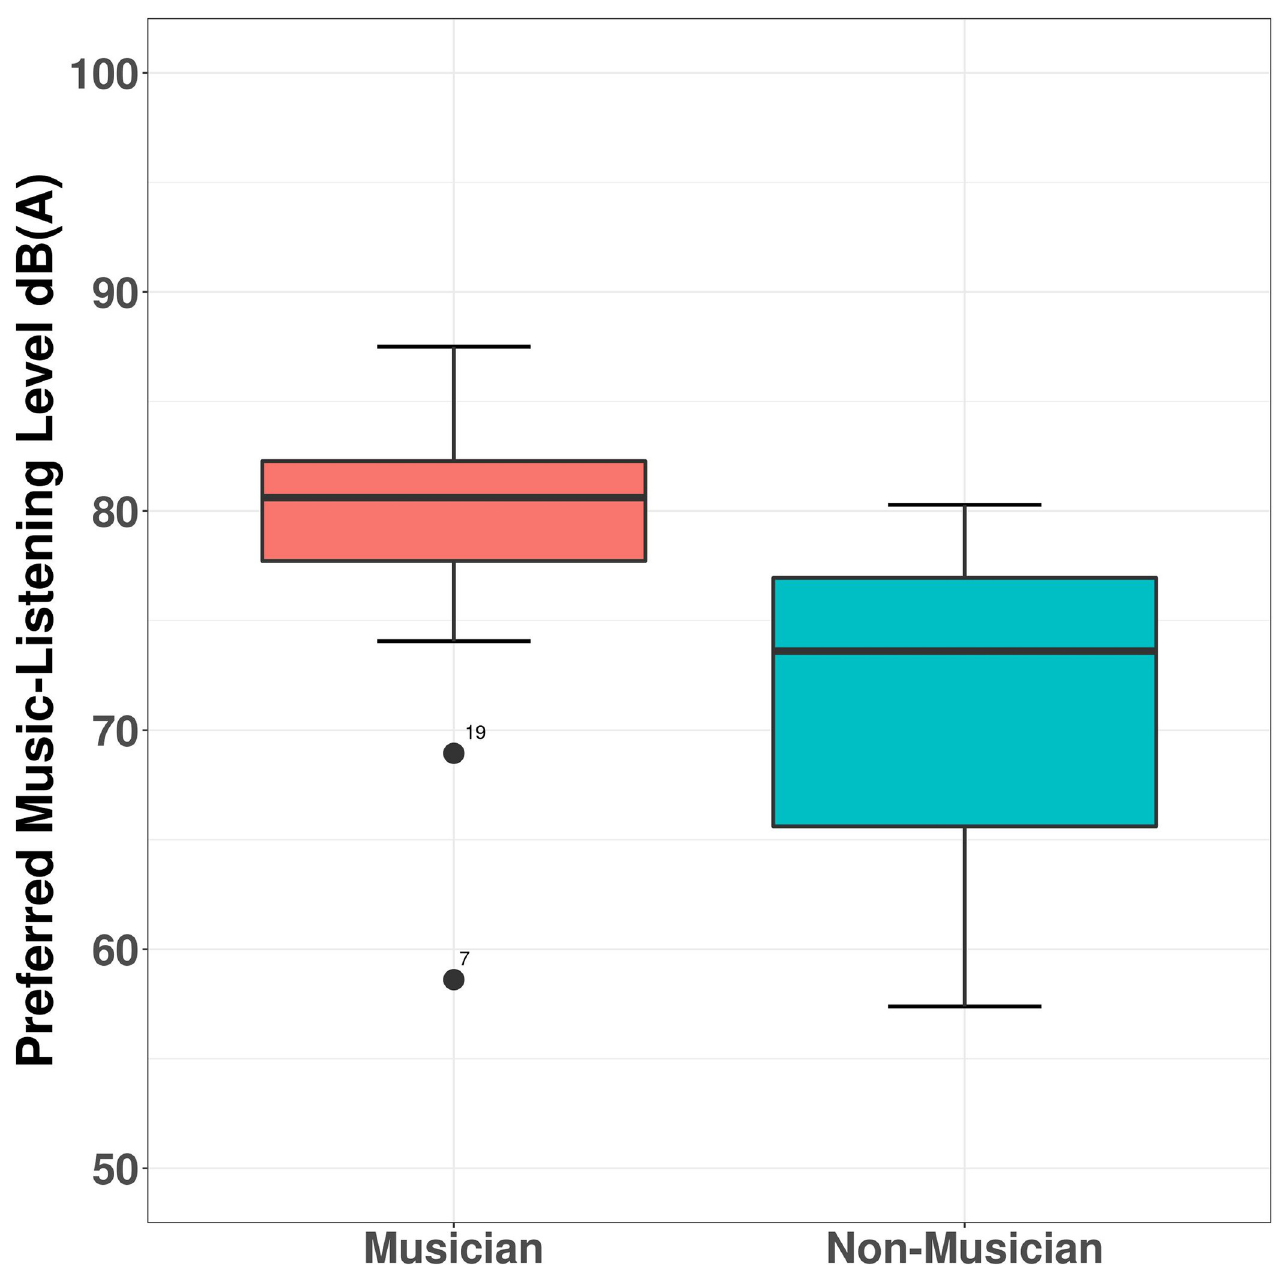
Fig 2. Preferred music-listening level for musicians and non-musicians. The boxplots show the smallest observation, 25% quantile, median, 75% quantile and the largest observation.